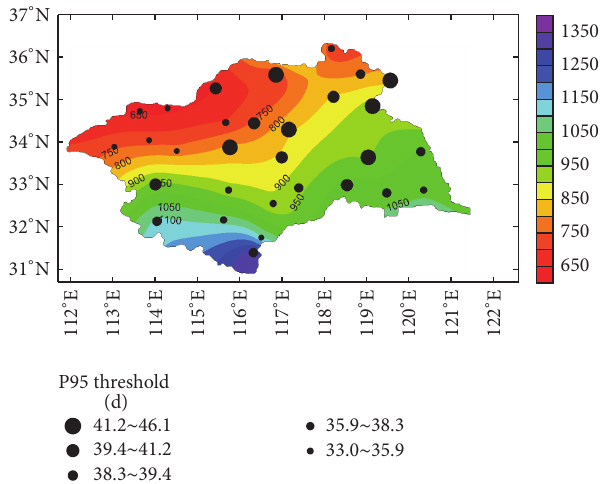
Figure 7: Spatial distribution of extreme precipitation threshold of P95 versus annual